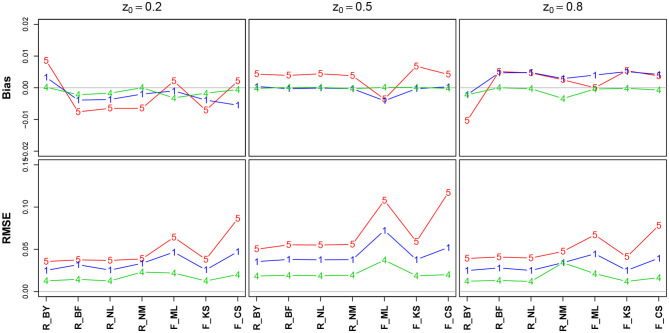
Bias (upper row) and RMSE (lower row) of the starting point parameter z. red line/symbol “5”: 50 trials; blue line/symbol “1”: 100 trials; green line/symbol “4”: 400 trials; for abbreviations see Figure 3.